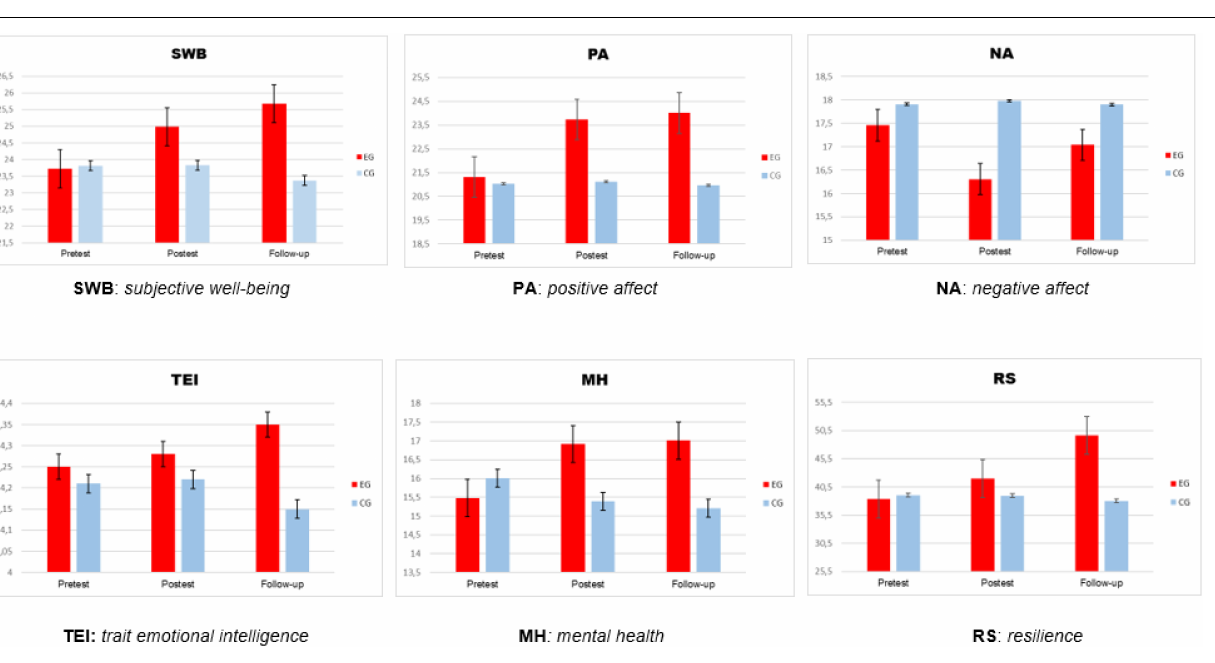
of the EG. The size of the effect was low-effect size ( µ 2 =